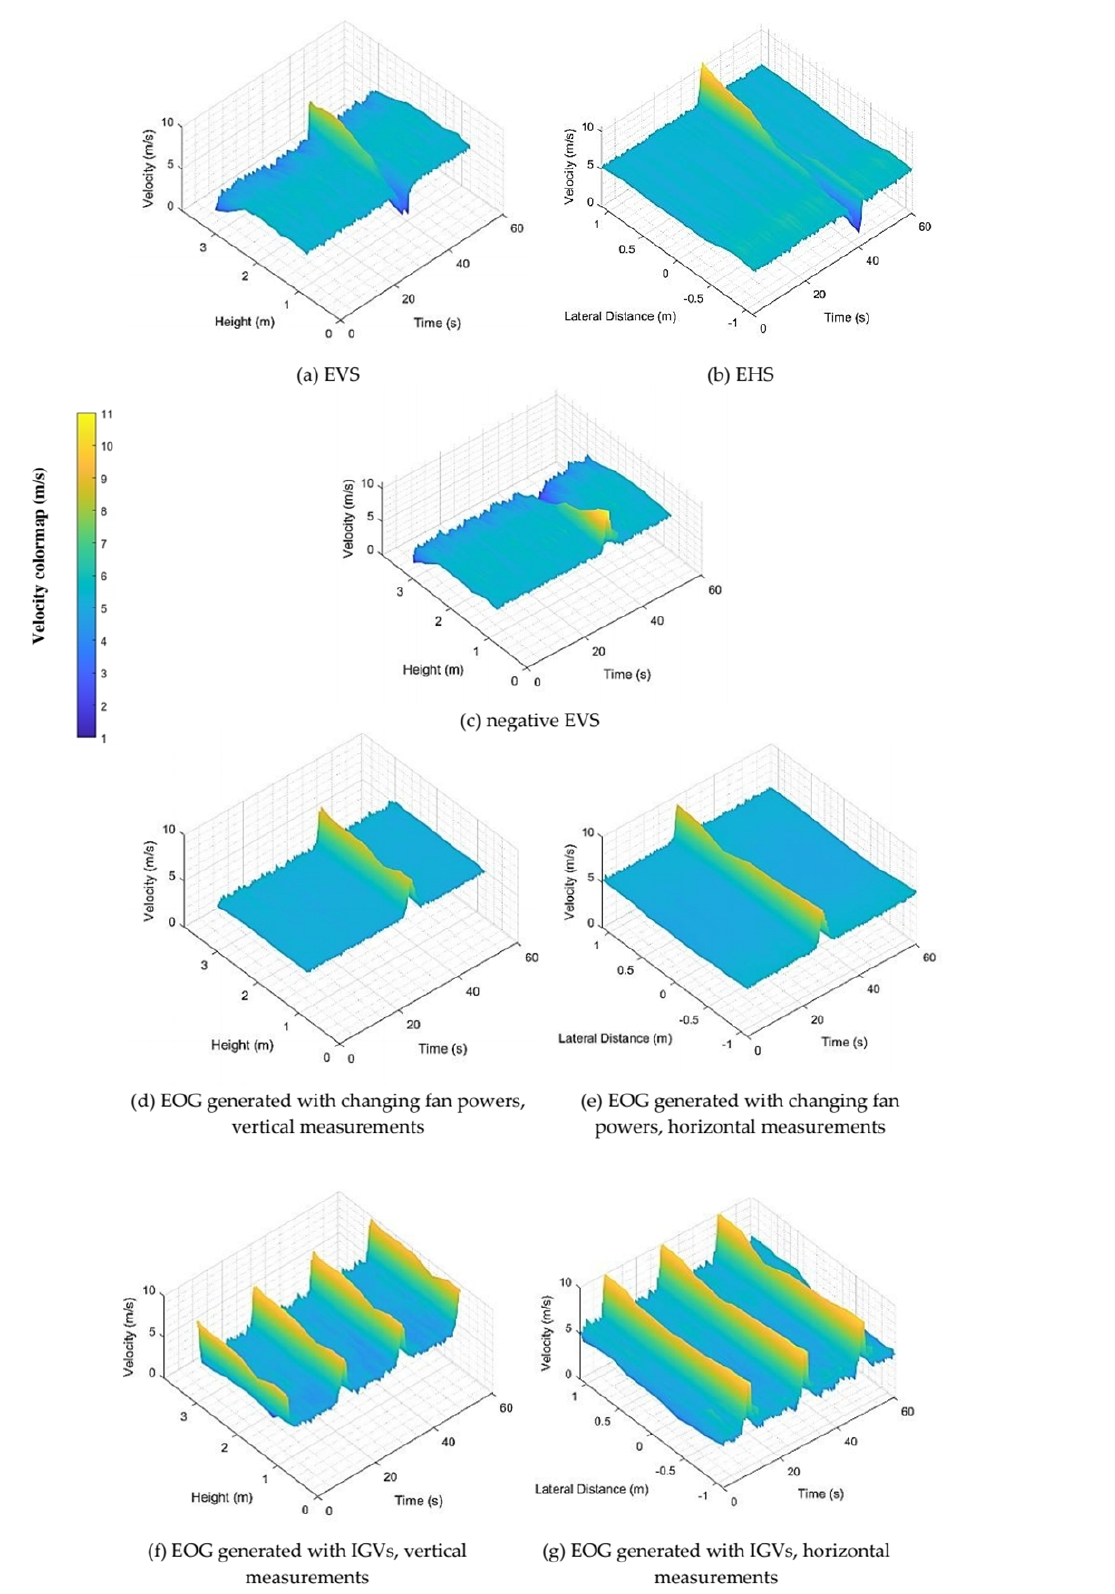
Figure 11. The 3D pictures of the complete time history of the phased averaged (with 0.2s averaging window) turbulent velocity